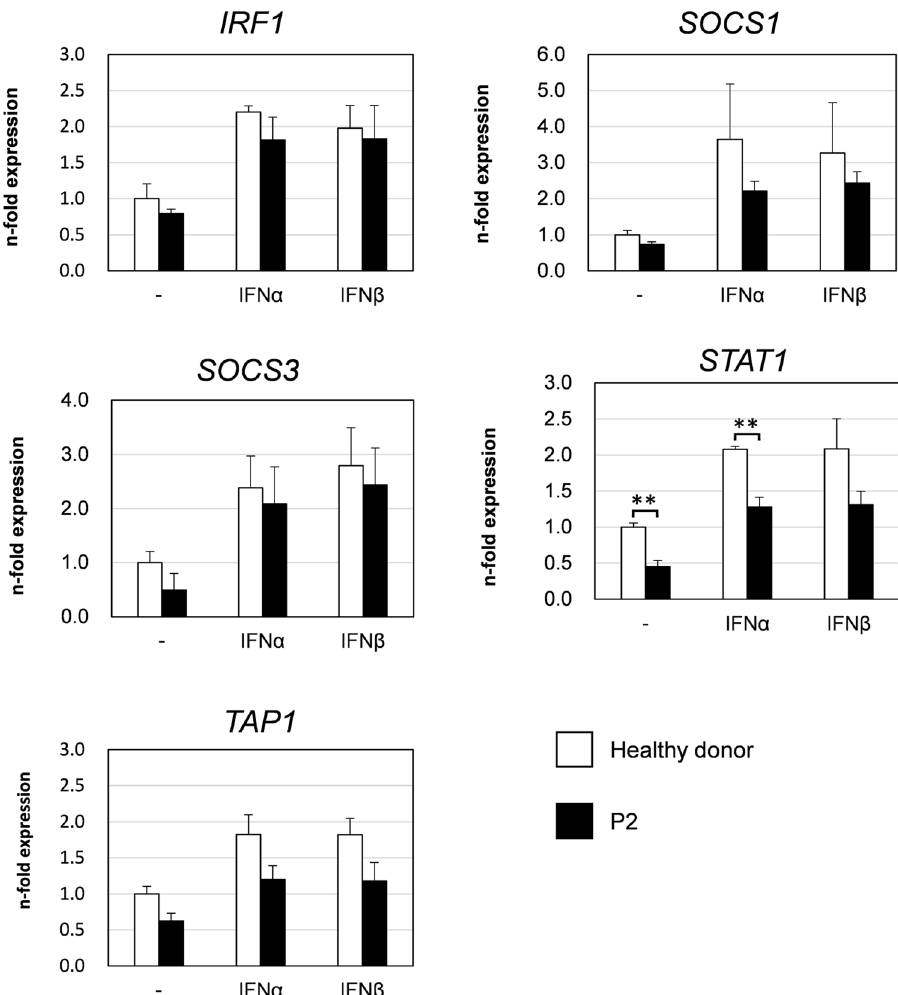
Figure 4. Analysis of type I IFN-inducible gene induction in EBV-BCLs from a healthy donor and the patient. Cells were stimulated with IFN- α (1000 U/mL), IFN-ß (500 U/mL) or without any IFN for 2 h. The cDNAs generated from the total RNA were quantified with qPCR assays. The expression levels of IRF1 , SOCS1 , SOCS3 , STAT1 and TAP1 mRNAs were determined by normalizing each with cyclophilin B levels. The induction level is presented as n-fold expression that in the untreated healthy donor cell control, which was set as 1. The data are derived from three independent experiments using 3 EBV-BCLs per genotype. Data represent mean ± SEM. ** P < 0.01. P values were derived from 2-tailed Student’s